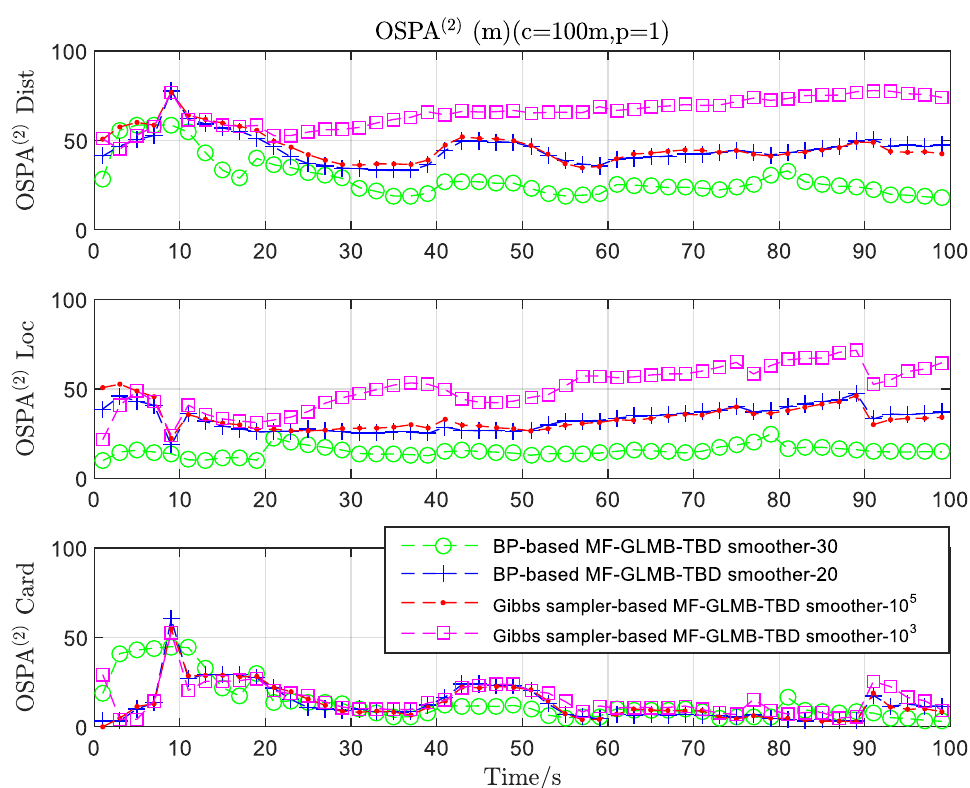
Figure 7. OSPA (2) error versus time for the final estimation from different implementations of the MF-GLMB-TBD smoother.